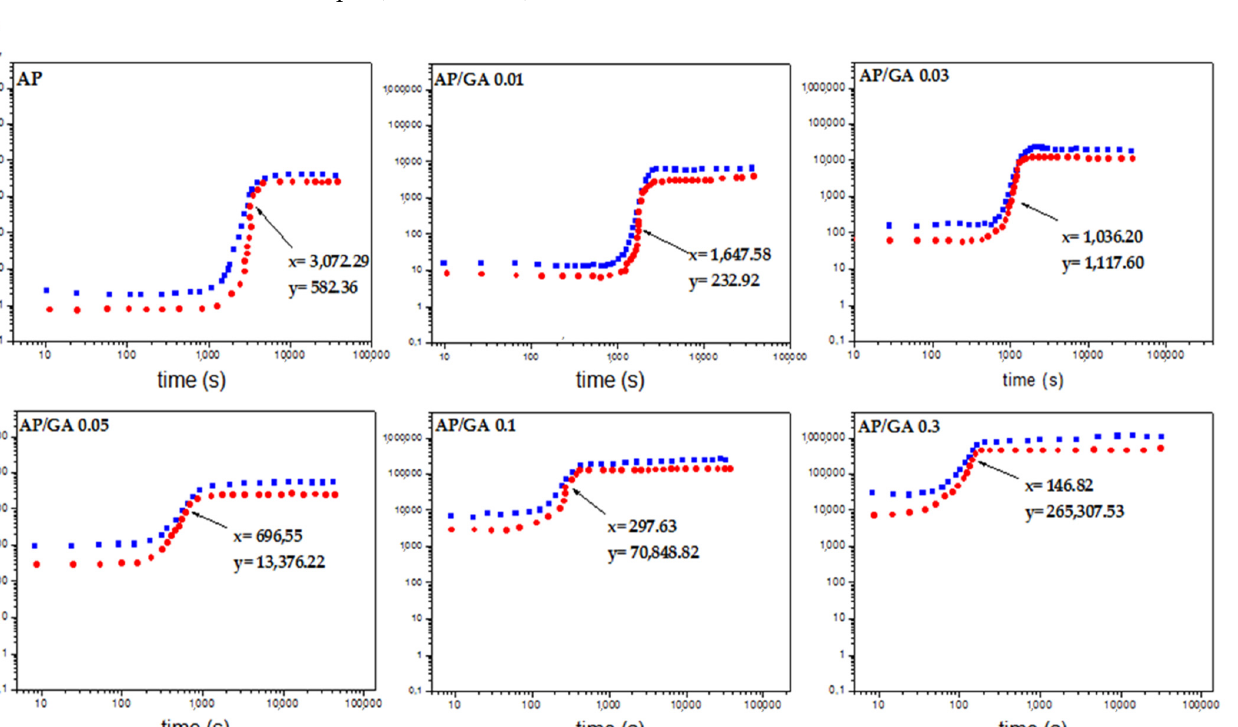
Figure 7. Complex viscosity ( η *) vs. time of AP and AP/GA samples. The pull-off method was used to evaluate the mechanical adhesion resistance of the silica based coatings with the DH36 steel sheet. As detailed in Section 2, the test is performed by fixing small dollies perpendicular to the metallic specimens (Figure 8a).